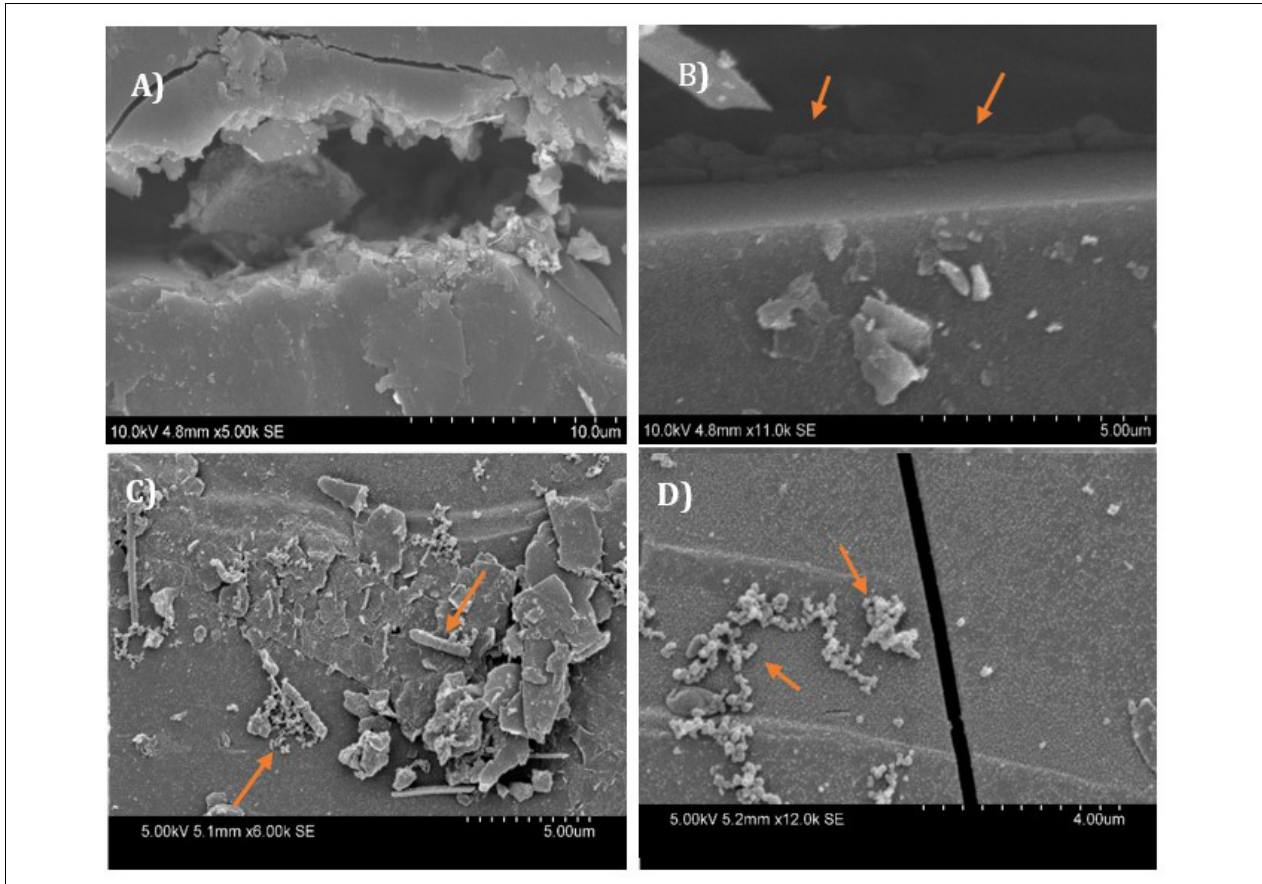
FIGURE 6 | Electron microscopy images of the Jharia coal samples, inoculated with a coal seam associated microbial community in groundwater and treated with neutral red. The HDMS method was used to prepare the coal samples, for the electron microscopy. Image (A) is showing a natural fracture at the coal surface. Microbes can also be seen inside these natural fracture (B) , and over the surface of coal (C,D) . Arrows showing the bacterial colonies/archaea, inside and on the surface of the coal.